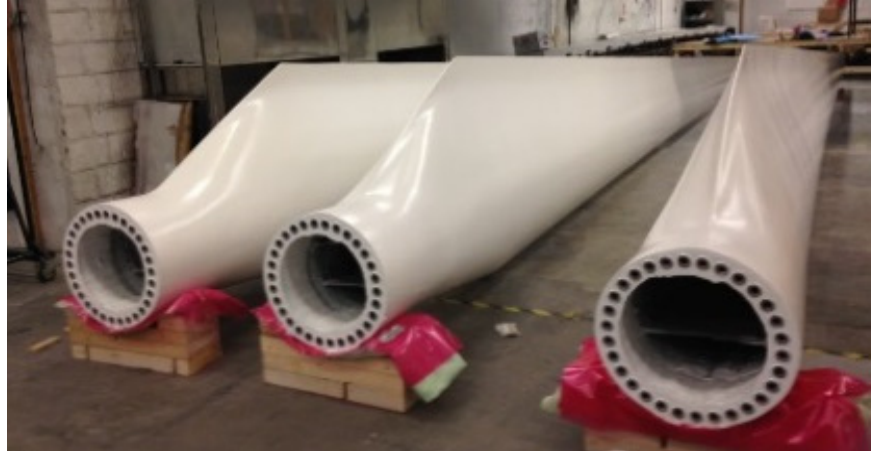
Figure 2. 13 m wind turbine blade after being manufactured and finished.